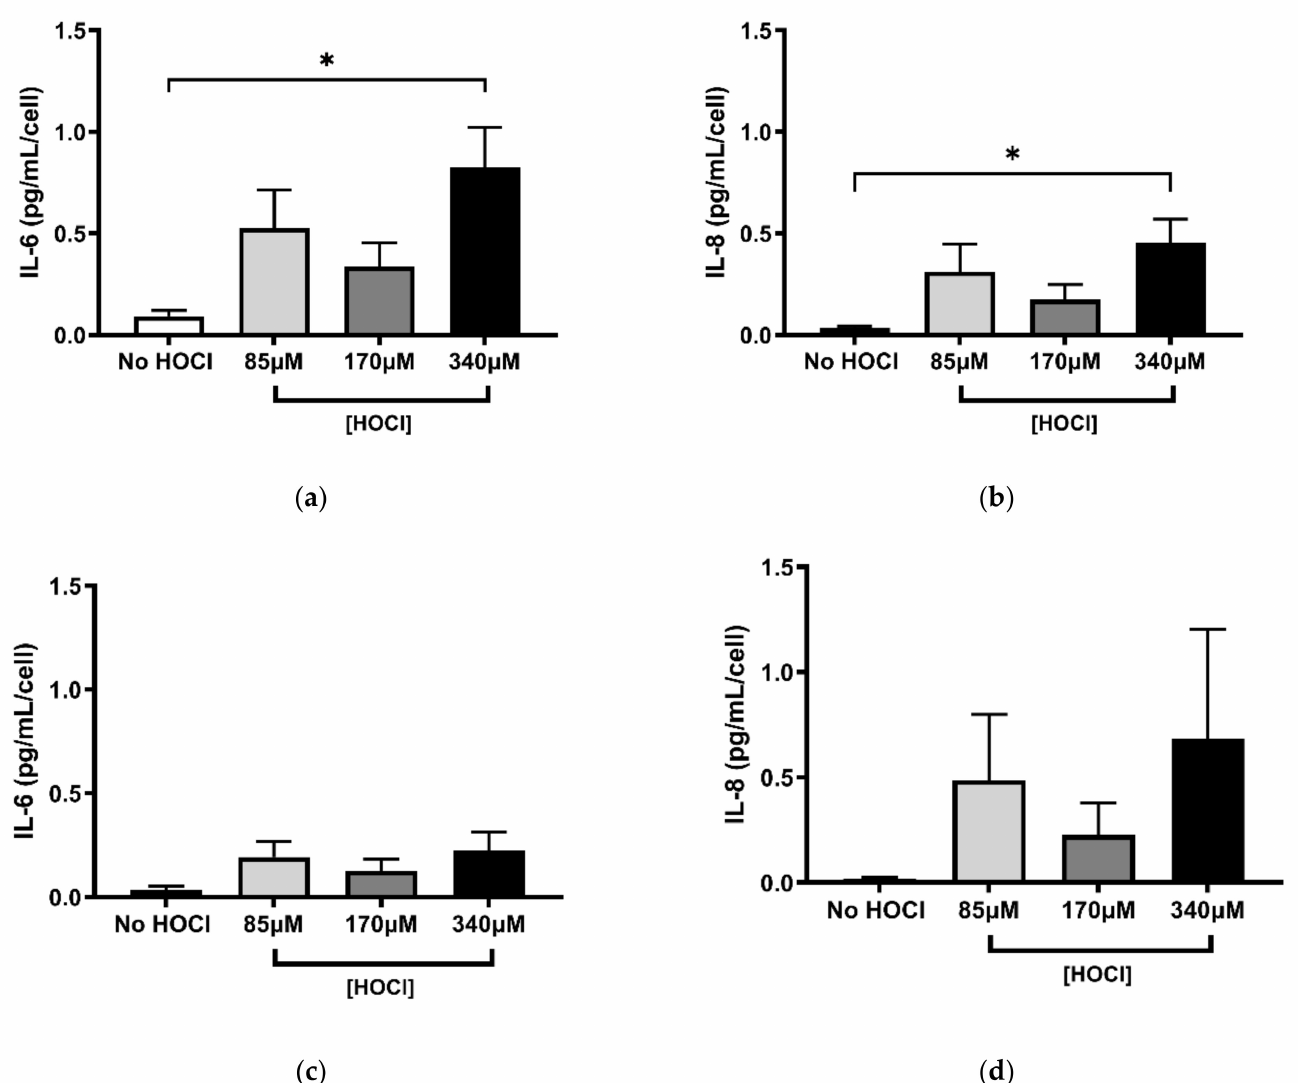
Figure 3. Effects of HOCl-oxidized cell-derived ECM on fibroblasts’ secretion of inflammatory cytokines. Fibroblasts were grown on BEAS-2B-derived ECM oxidised with (or without) HOCl (85 µ M, 170 µ M, and 340 µ M) and supernatants were collected after 24 h ( a , b ) and 96 h ( c , d ) to measure the concentrations of IL-6 A, C and IL-8 B, D by ELISA. Results were obtained as picograms per microlitre per cell (normalised against the cell counts at 24 h and 96 h post-seeding) and are expressed as mean ± SEM. A, B, C, D n = 5. * p < 0.05, significance was compared against No HOCl control; one-way ANOVA with Dunnett’s multiple comparison test was